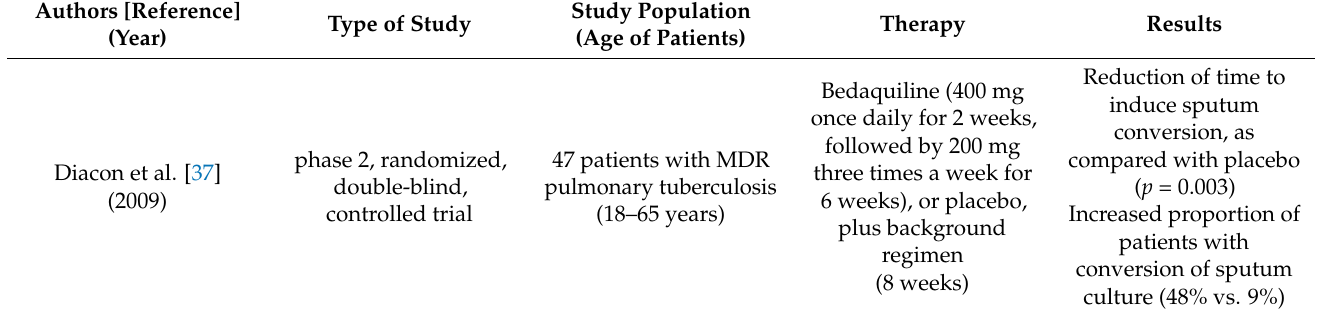
Table 2. Principal studies on the effectiveness of bedaquiline treatment in